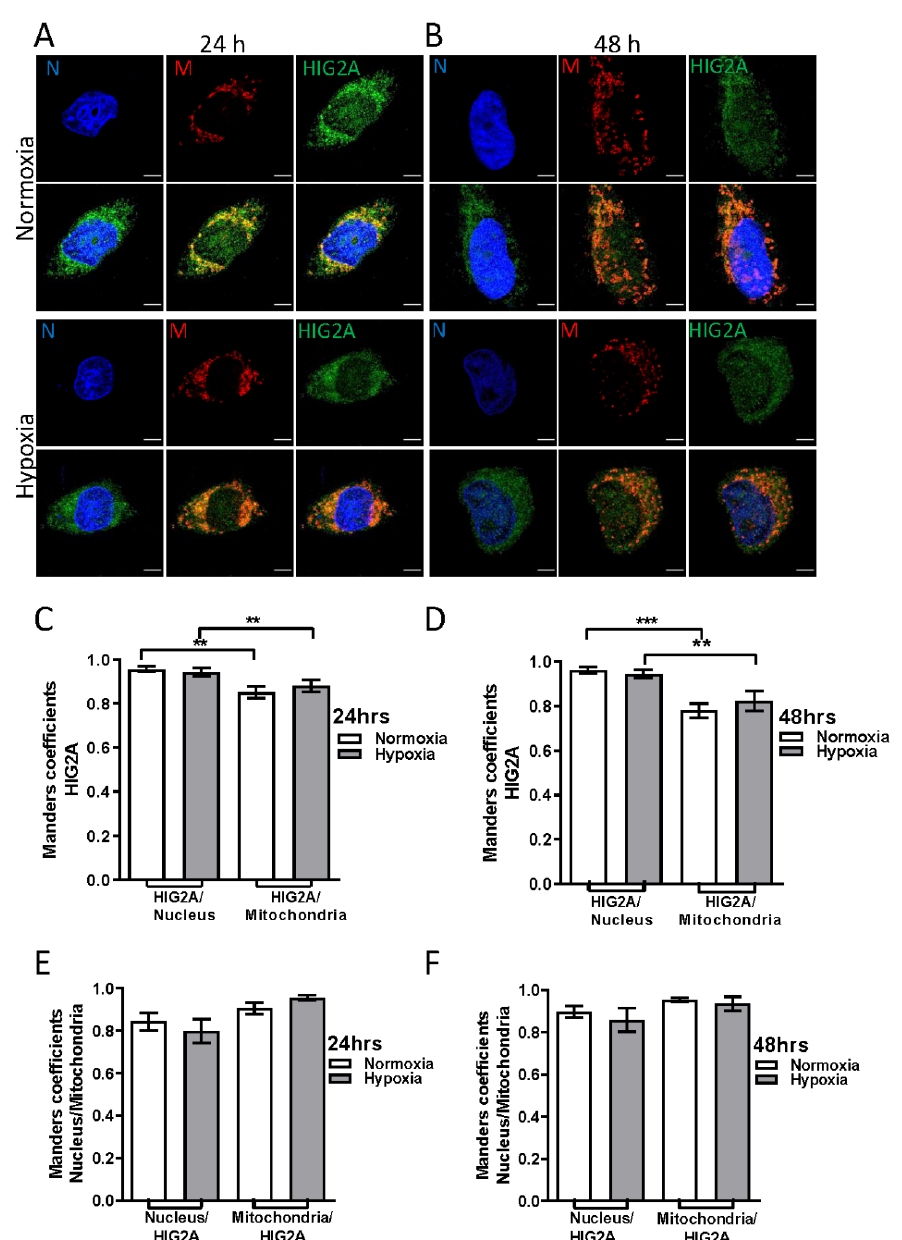
Figure 2. The effect of hypoxia on the subcellular localization of HIG2A in the mitochondria and the nucleus of HEK293 cells. The representative immunofluorescence images in HEK293 cells; anti- HIG2A primary antibody (Abcam ab135399), DyLight ® 488 secondary antibody (HIG2A green). MitoTracker TM Red CM-H2XRos mitochondrial fluorescent marker (M red). Hoescht 33342 (blue signal—DNA). Z-axis series were obtained using confocal microscopy (Leica TCS SP8). The separation between each of the slices (Z step size) was 0.130 microns. The HEK293 cells were subjected to hypoxic stress (2% O 2 ) for 24-h ( A , C , E ) and 48-h ( B , D , F ). The quantification of colocalization was performed by Manders’ coefficient. The fluorescence signal corresponding to HIG2A was quantified over the fluorescence signal of the nucleus (HIG2A/nucleus [M2]) ( C , D ) and over the signal of the mitochondria (HIG2A/mitochondria [M1]) ( C , D ). Each bar graph represents the mean ± SE, n = 4 biological replicates, 20 cells were analyzed per condition; they were analyzed by a one-tailed t -test ( p < 0.05), followed by a Mann-Whitney test. Statistical differences were found with a significance of p -value (** p ≤ 0.0011 ( C ), *** p ≤ 0.0001 ( D ); ** p ≤ 0.0029 ( D )). ** Very significant (0.001 to 0.01). *** Extremely significant (0.0001 to 0.001). The white bars indicate a 5 µ m